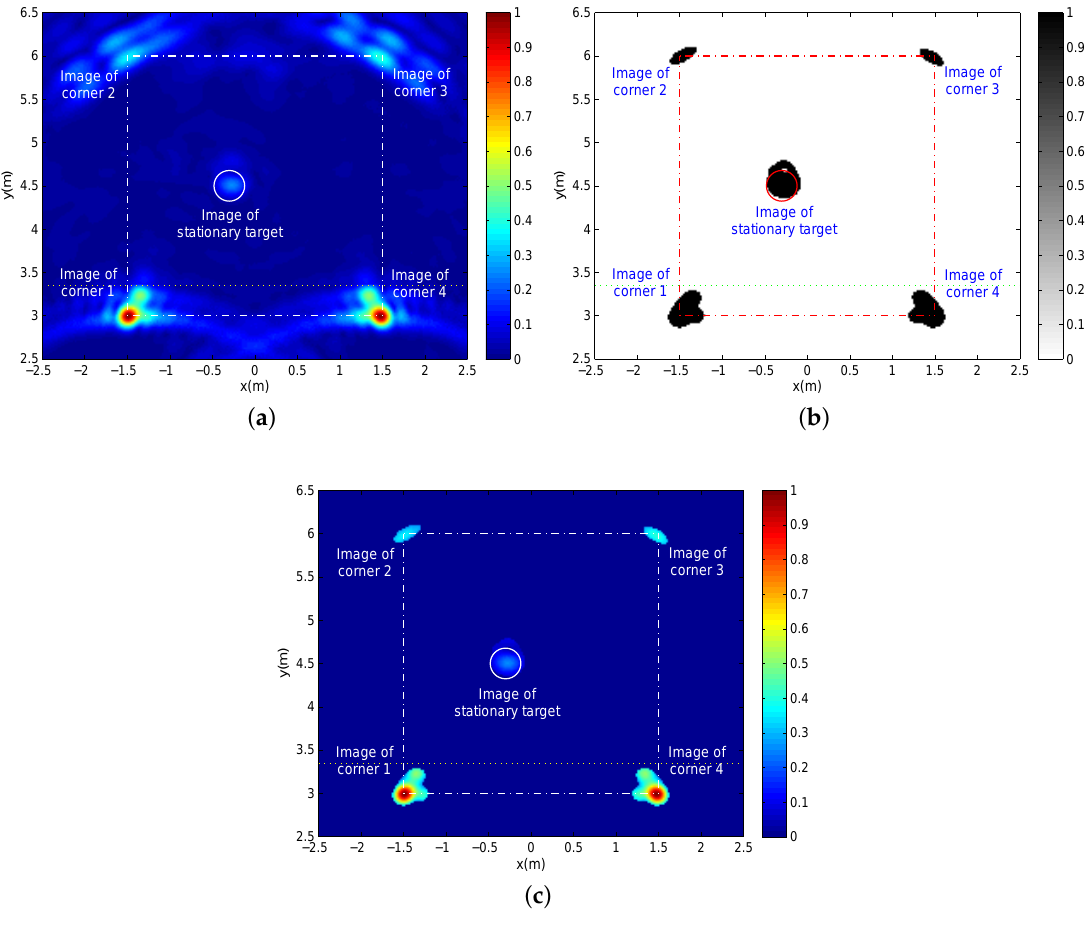
Figure 8. ( a ) The panorama image after additive fusion; ( b ) The binary panorama image after two-dimensional cell-averaging constant-false-alarm-rate (2D CA-CFAR) detection on ( a ); ( c ) The panorama image maintaining all corner and target images with the original pixel values after 2D CA-CFAR detection on ( a